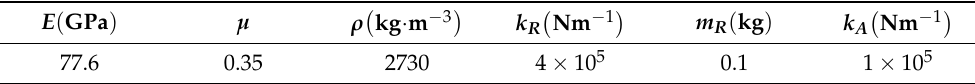
Table 4. Geometric parameters used in calculations in Figure 4.